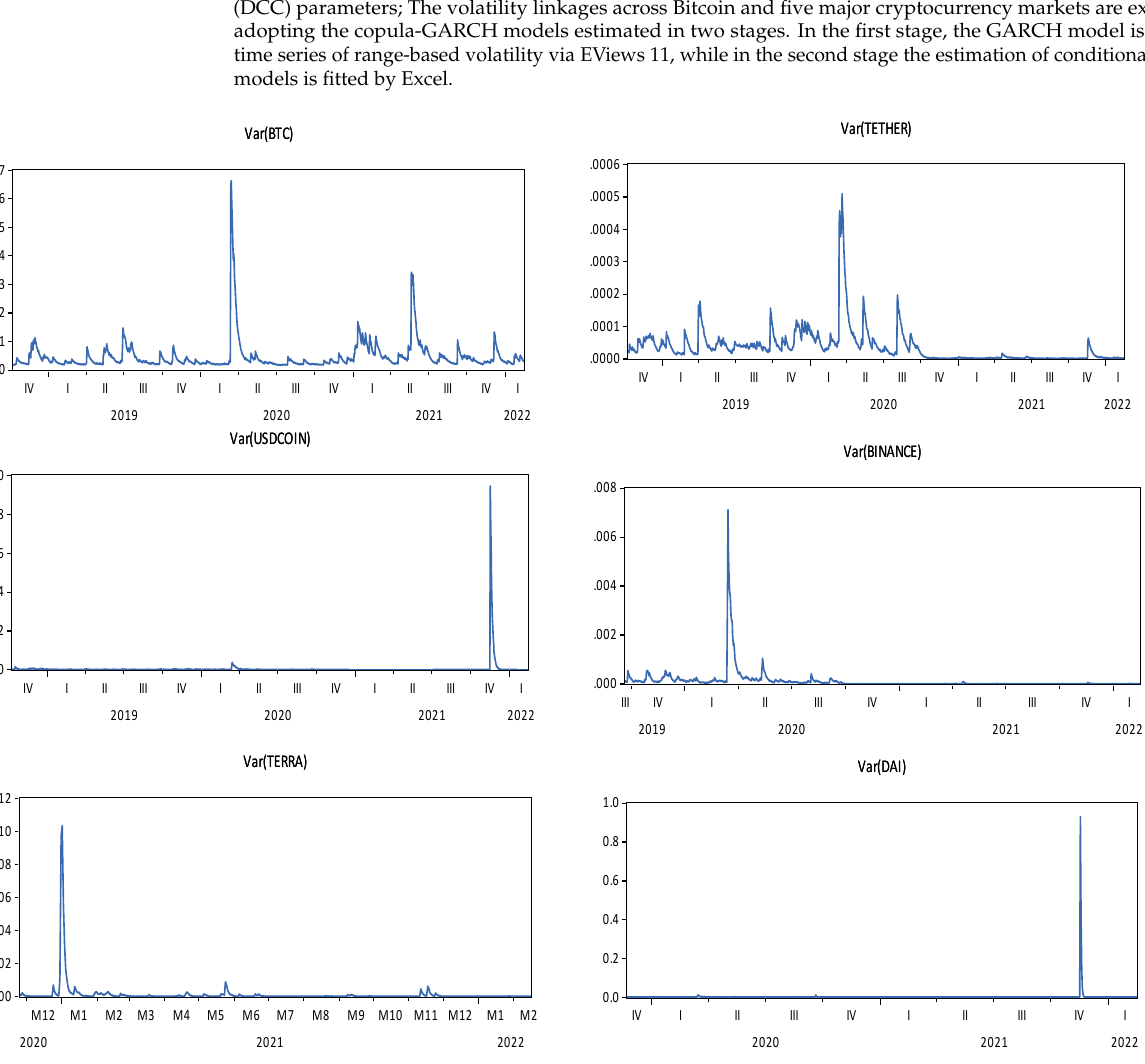
Figure 3. Conditional variance for the Bitcoin and top five stablecoins based on the VAR–BEEK– GARCH model.